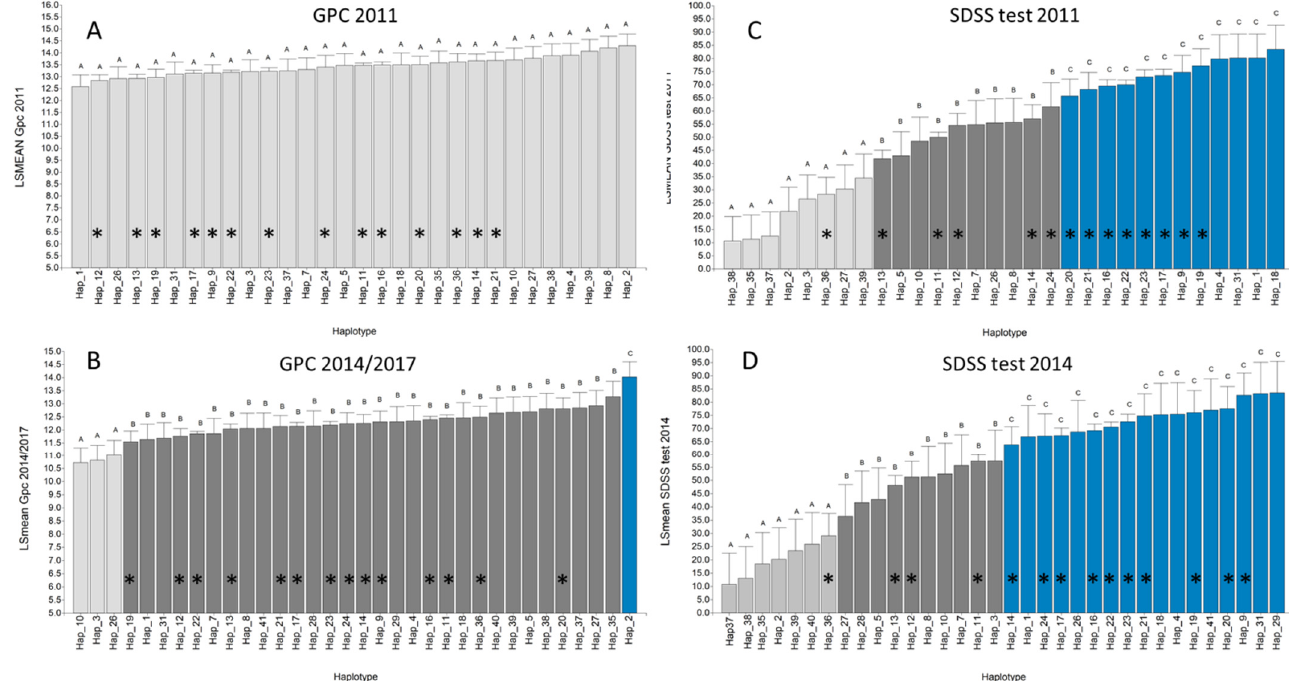
Figure 3. Multiple comparison test (BSS) between haplotypes considering the LSMEANs of grain protein content (GPC) and sodium dodecyl sulfate micro-sedimentation (SDSS) test by year (2011 ( A , C ) and 2014 ( D ) or grouping 2014/2017 ( B )). Bars with a symbol (*) represent haplotypes detected in at least two genotypes. Bars with different letters at the top and colours indicate significant differences according to the BSS test. Hap_: Haplotype_(number).